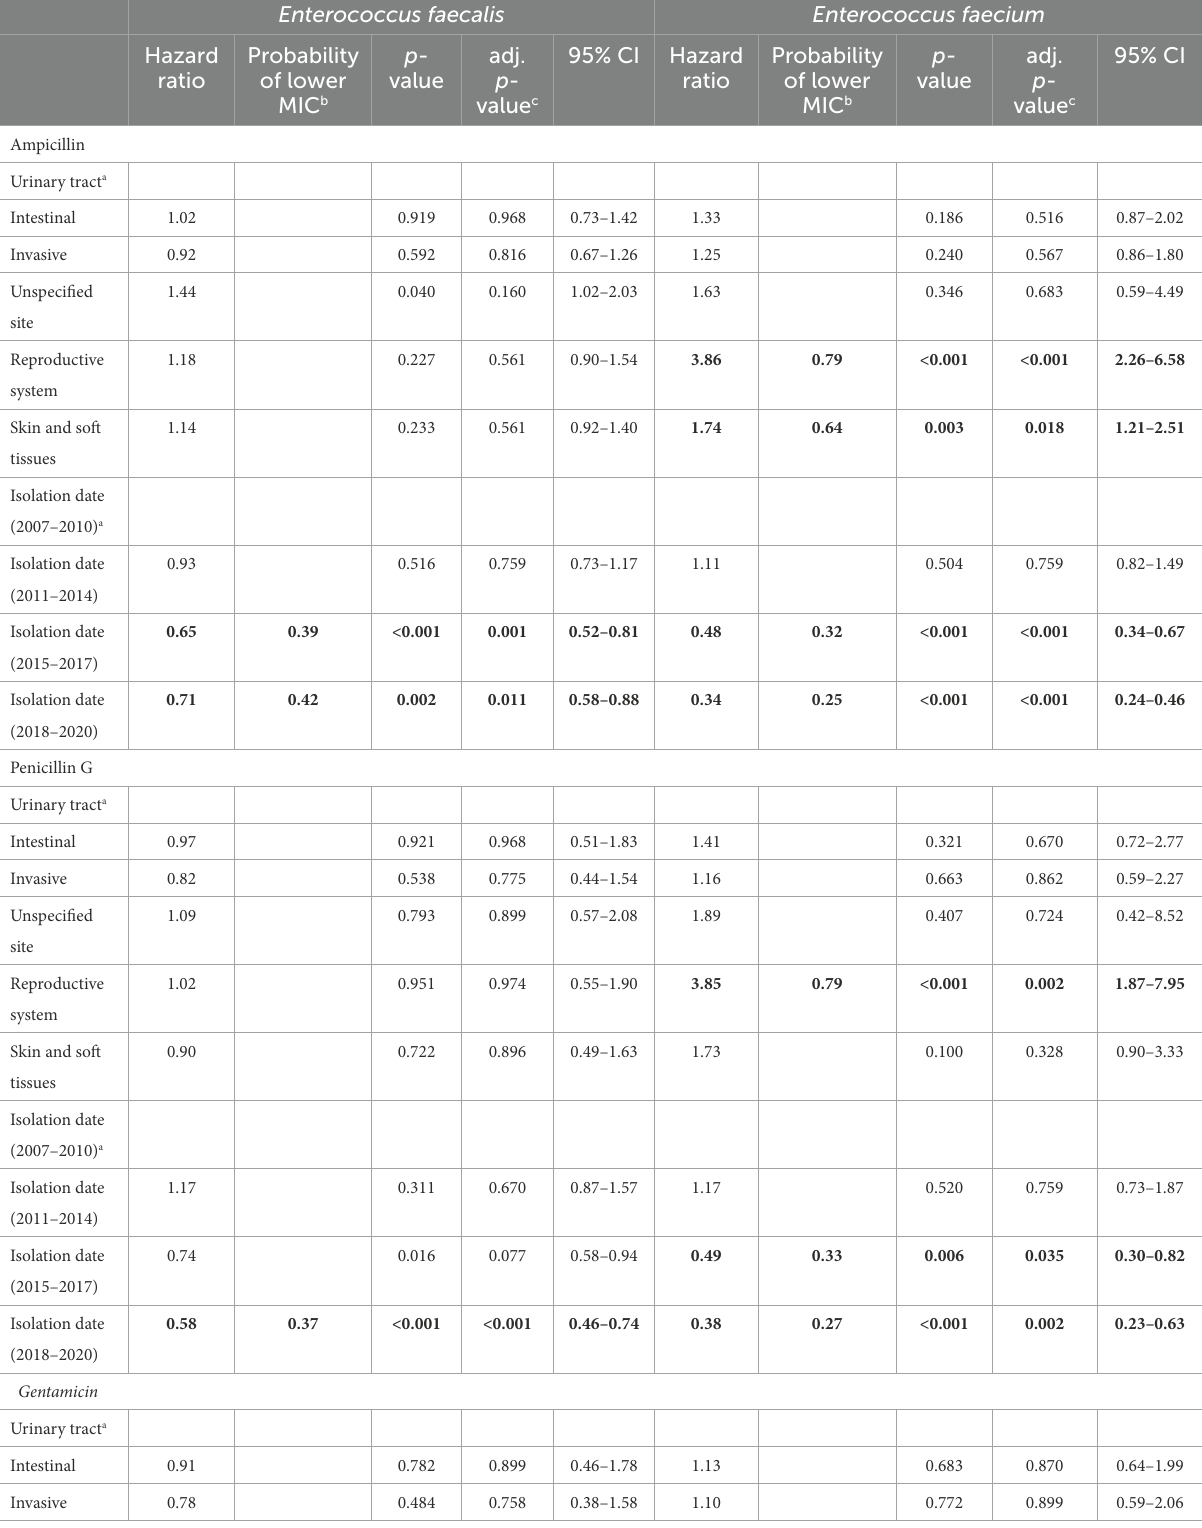
TABLE 4 Multivariable Cox proportional hazard regression model representing minimum inhibitory concentration trends of Enterococcus faecalis and Enterococcus faecium to different antimicrobials in this study, in canine clinical infections at the Cornell University Animal Health Diagnostic Center (AHDC),